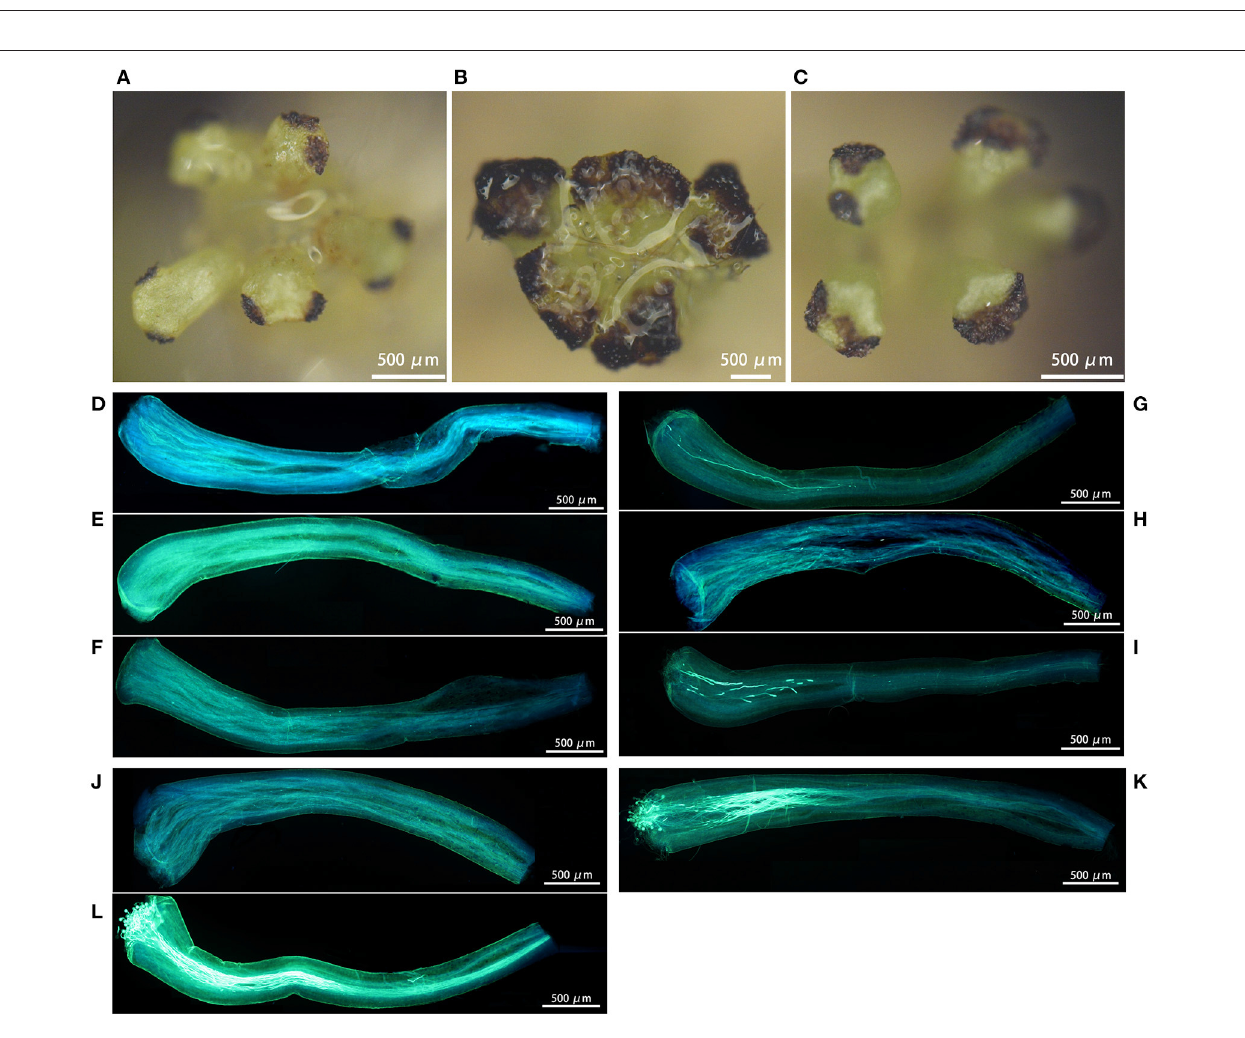
FIGURE 6 | Images of the stigmas receptivity test and pollens in situ germination: (A–C) the stained area showing the stigmas receptivity of H30-6, H411, and B336 respectively. (D–F) showing pollen in situ germination at 2, 3, and 4 days after H30-6 bagging natural pollination receptivity. (G–I) showing pollen in situ germination at 2, 3, and 4 days after H30-6 open pollination receptivity. (J–L) showing pollen in situ germination at 2 days after H30-6 artificial selfing, pollination with pollens of H411, and pollination with pollens of B336.